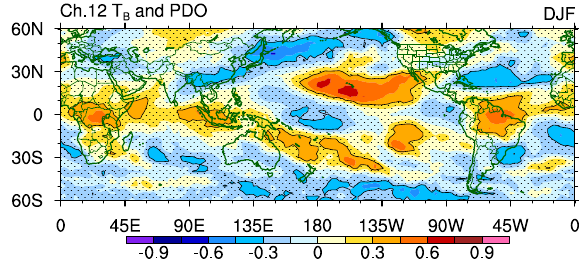
Fig. 7. Correlations between channel 12 T B and Niño 3.4 index for DJF. Grids that are considered insignificant using a t test are stip- pled to deemphasize them and are separated by contour lines.